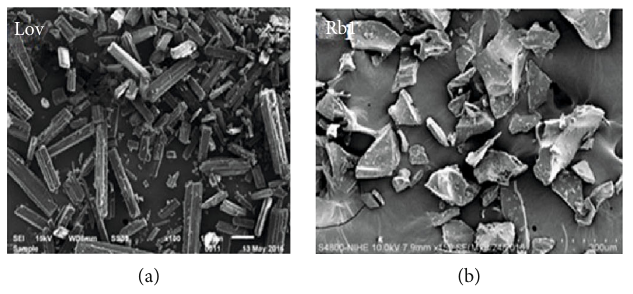
Figure 4: FESEM image of Lov (a) and ginsenoside Rb1 (b).